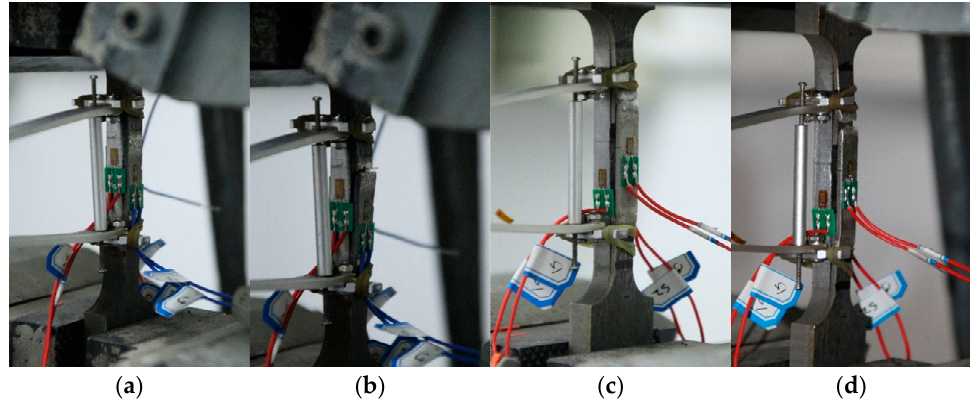
Figure 9. Fracture of clad-to-cover-plate welded joints. ( a ) Weld II, ( b ) Weld II, ( c ) Weld III, and ( d ) Weld III.